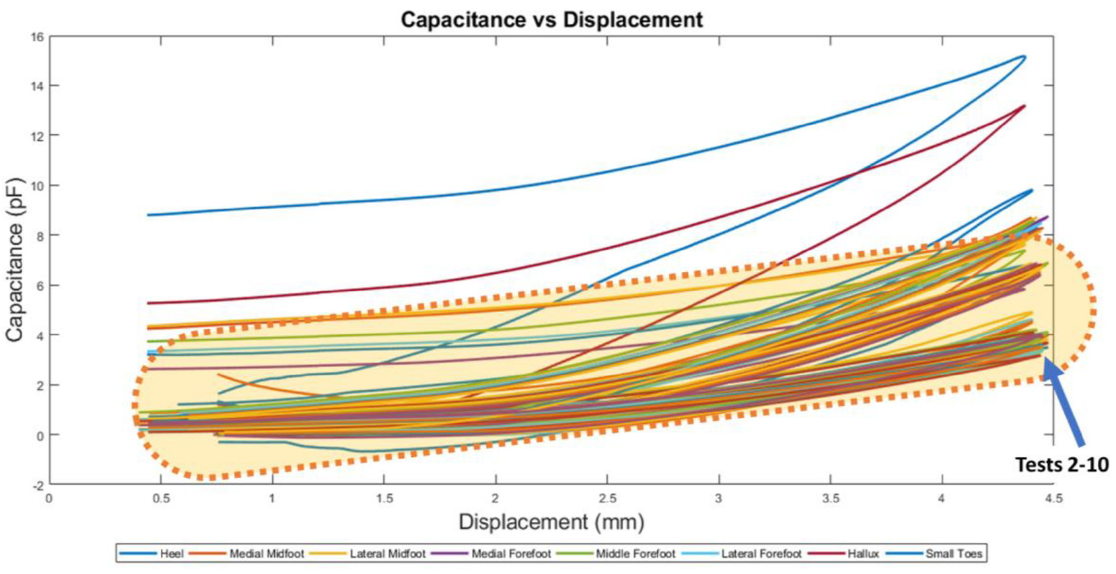
Figure 16. Capacitance and Displacement plots for 10 tests.